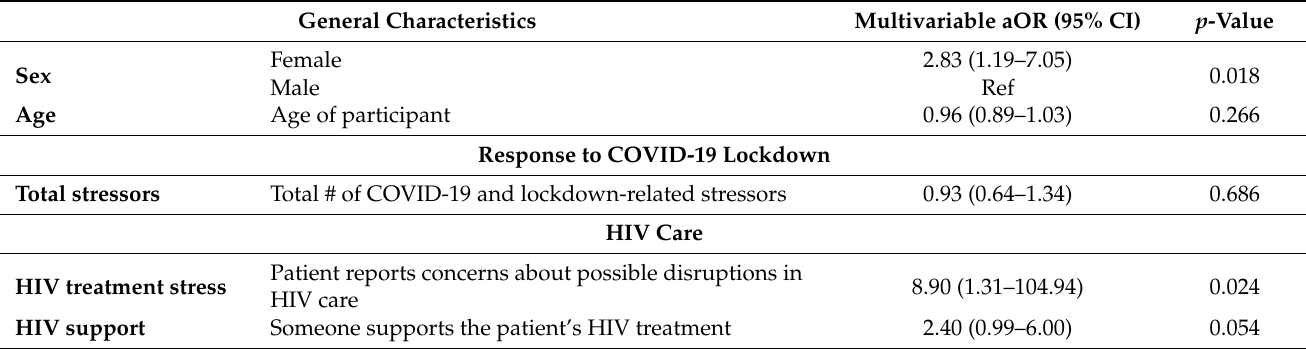
Table 3. Multicollinearity was not observed, with all VIFs <2.3. Table 3. Multivariate correlates of depressive symptoms among OPWH in Ukraine (n = 123) 1 . General